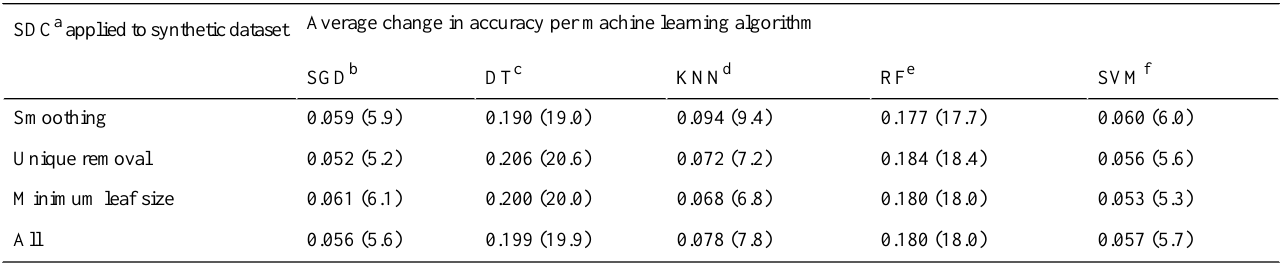
Table 8. Mean absolute difference in accuracy for each machine learning model and statistical disclosure control type. Average change in accuracy per machine learning algorithmSDC a applied to synthetic dataset